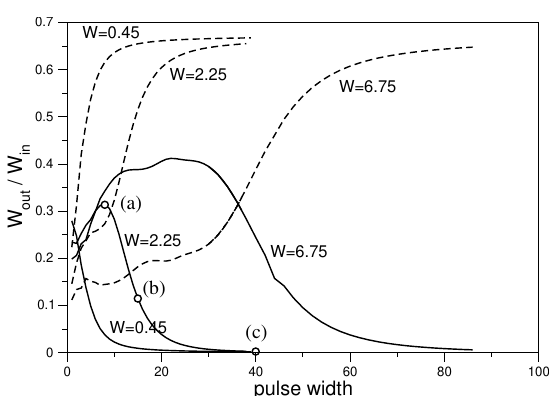
Figure 1. Normalised output energy at the excited core (solid lines) and second core (dashed lines) against input pulse width for three di ff erent energy pulses. Points (a), (b) and (c) corre- spond to cases with the same label in figure 2.